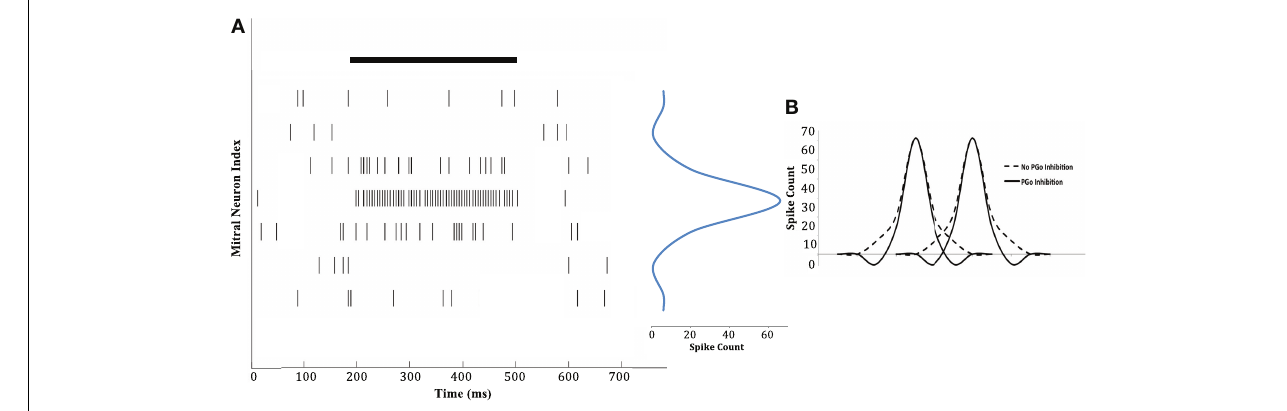
fourth row received input from the OSNs that responded most strongly, whereas the mitral cells depicted in the rows above and below it received progressively weaker OSN activity.The result is a sharply tuned population tuning curve (in blue) with a distinct inhibitory surround (the spike count is for the duration of the stimulus). (B) The representation of two different odors (two peaks) by a population of mitral cells (distributed along the abscissa in a one-dimensional chemotopic ordering for illustrative purposes). Non-topographical feed-forward (PGo) inhibition generates an inhibitory surround and reduces the overlap of the two combinatorial odor representations (solid line) compared to the overlap that would occur in the absence of PGo inhibition (dashed line).